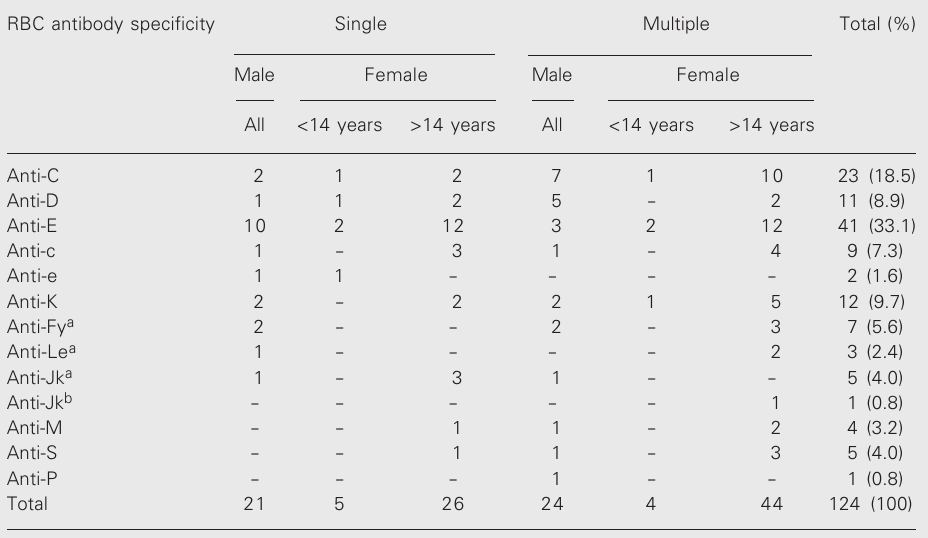
Table 1. Specificity of single or multiple IgG alloantibodies in 82 patients with sickle cell disease. RBC antibody specificity